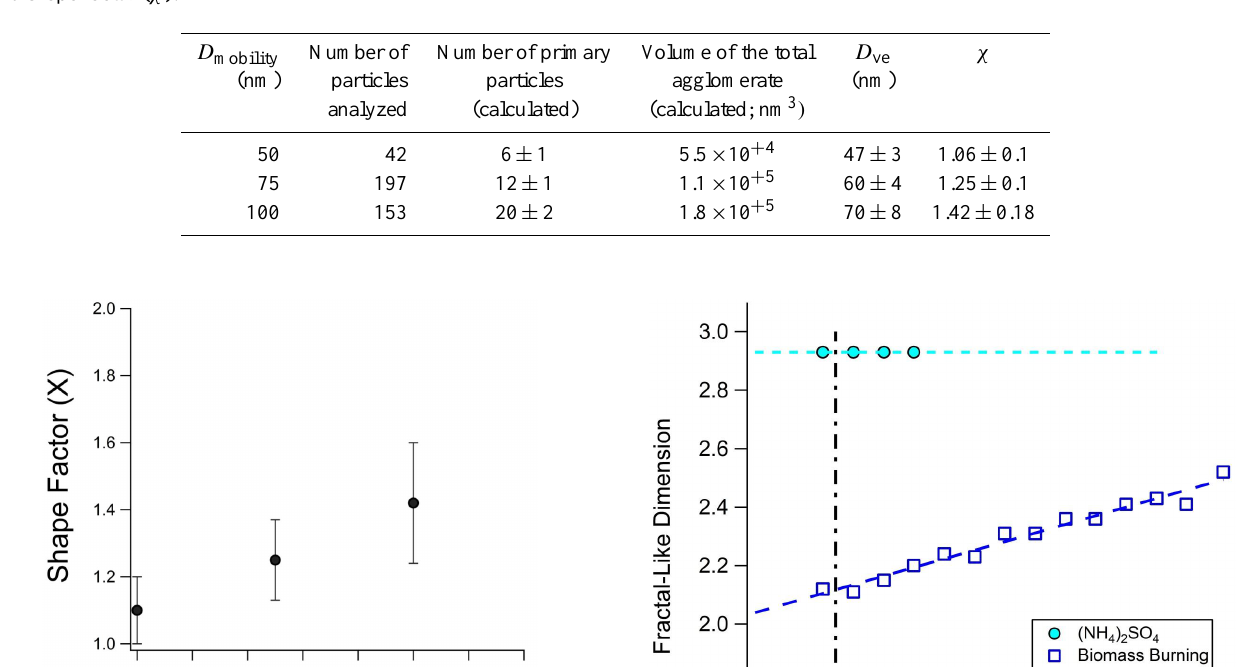
Table 1. The number of particles analyzed from TEM images of the mobility diameters ( D mobility ) of particles selected with the APM– SMPS–TEM system for freshly emitted biomass burning. Equations (7) and (8) are used to calculate the volume equivalent diameter ( D ve ) and shape factor ( χ ).